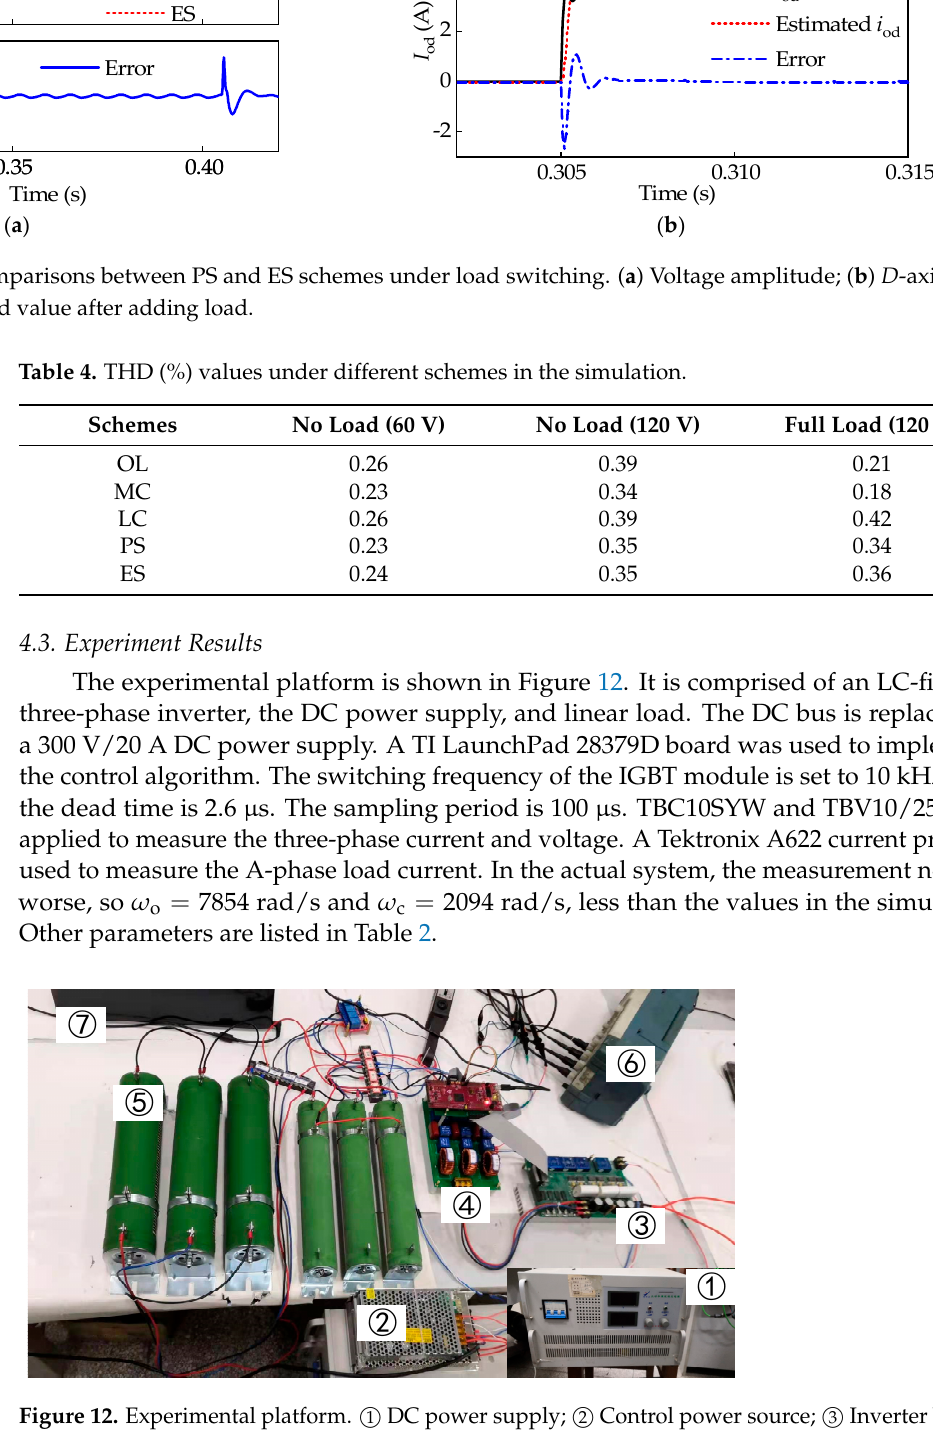
( b ) Figure 13. Experimental results under the reference voltage change: ( a ) Original LADRC scheme; ( b ) Proposed scheme. As shown in Figure 14, the voltage of the OL and PS schemes track well the reference voltage, 60 V and 120 V, and can recover within 4 ms, but the overshoot of the OL scheme is up to 134 V, which is greater than the PS scheme. The amplitude of the capacitor voltage is calculated from represents the i -phase voltage sampled by the oscilloscope. -0.02 OL PS Figure 14. Amplitude of capacitor voltage under the reference voltage step.